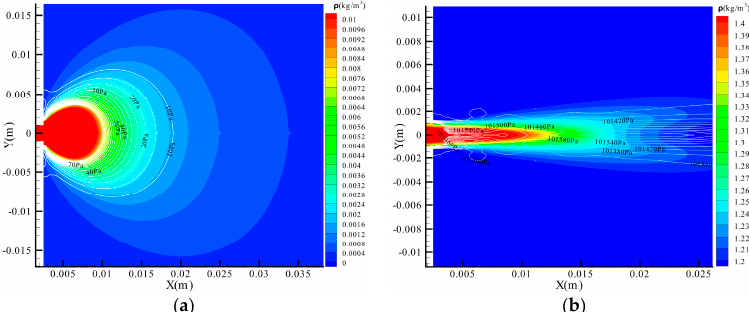
Figure 6. Density contour with pressure contour map of different external environment. ( a ) vacuum environment; ( b ) atmospheric environment. environment; ( b ) atmospheric environment.